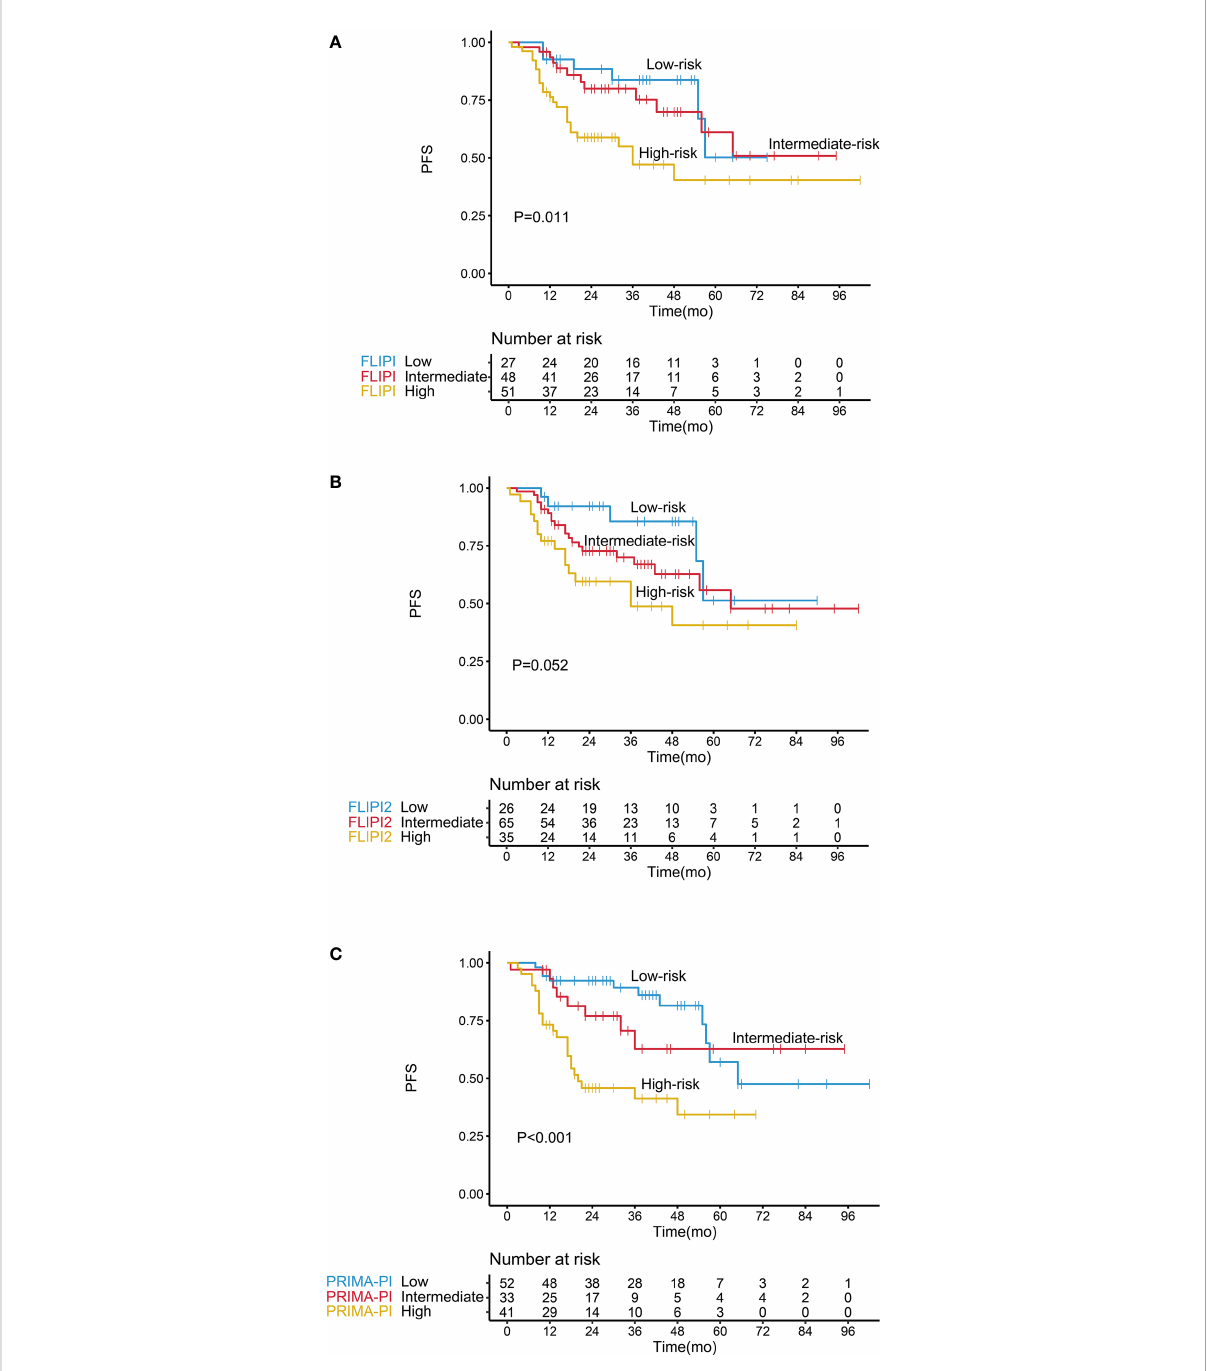
FIGURE 5 Kaplan – Meiersurvival analysis of progression-freesurvival infollicularlymphomapatients accordingtodifferentprognosticmodels,including (A) FLIPI, (B) FLIPI2, and (C)